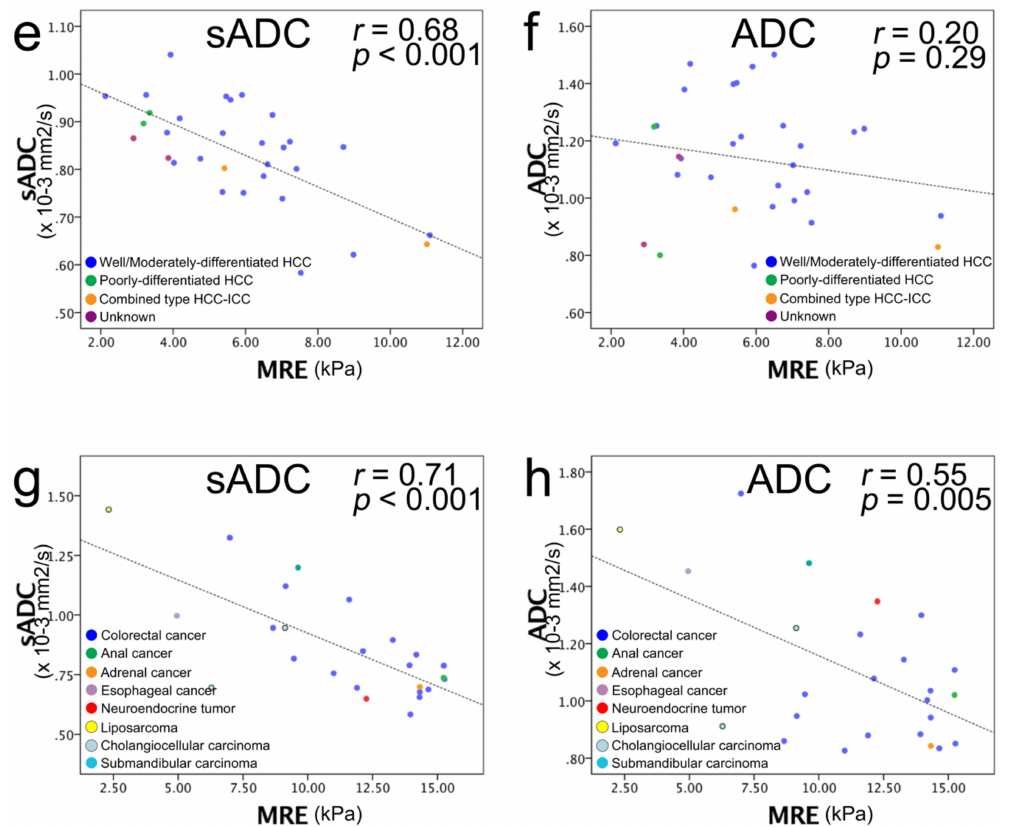
Figure 4. Scatter plots of MRE shear modulus ( µ MRE ; kPa) (horizontal line) versus ADC value (vertical line). ( a ) sADC versus µ MRE of liver parenchyma and ( b ) ADC versus µ MRE of liver parenchyma. ( c ) sADC versus µ MRE of the entire liver tumor and ( d ) ADC versus µ MRE of HCC and metastasis: blue dots, HCC; green dots, metastasis. ( e ) sADC versus µ µ MRE of HCC, and ( f ) ADC versus MRE of HCC: blue dots, well/moderately differentiated HCC; green dots, poorly differentiated HCC; yellow dots, combined type HCC–ICC; purple dots, unknown histology. A strong correlation was observed between sADC and µ MRE , and no correlation was observed between ADC and µ MRE . ( g ) sADC versus µ MRE of metastasis and ( h ) ADC versus µ MRE of metastasis: blue dots, colorectal cancer; green dots, anal cancer; orange dots, adrenal cancer; purple dots, esophageal cancer; red dots, neuroendocrine tumor; yellow dots, liposarcoma; light blue dots, cholangiocelluar carcinoma; turquoise blue dots, submandibular carcinoma. A strong correlation was observed between sADC and µ MRE , and a moderate correlation was observed between ADC and µ MRE . The black dashed line corresponds to the linear regression of sADC/ADC versus the MRE values, and not to the VMRE calibration line, which was calculated from the symmetric correlation of the MRE values with ln(S 200 /S 1500 ), according to Equation